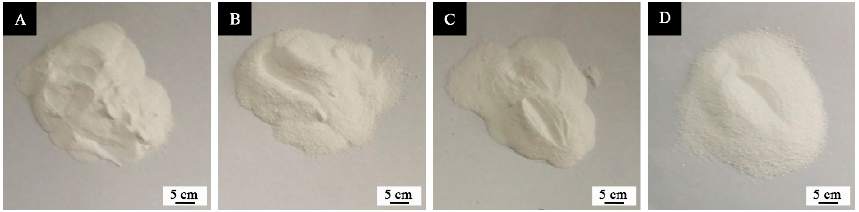
Figure 2. The macroscopic images of microcapsule powder: ( A ) sample 1#, ( B ) sample 2#, ( C ) sample 3#, ( D ) sample 4#.